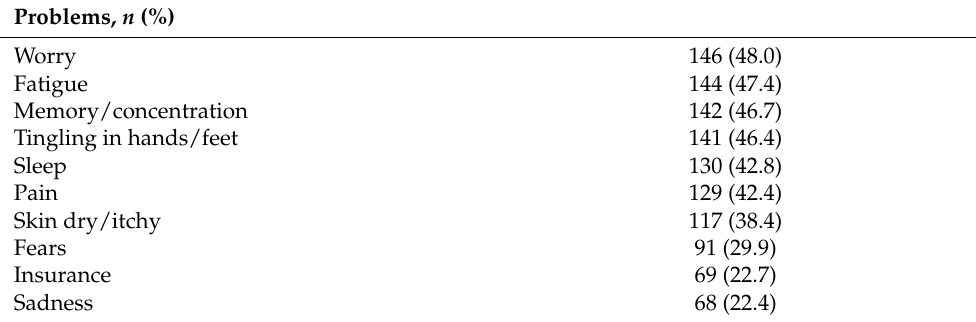
Table 4. Top 10 issues in problem list ( N = 304).